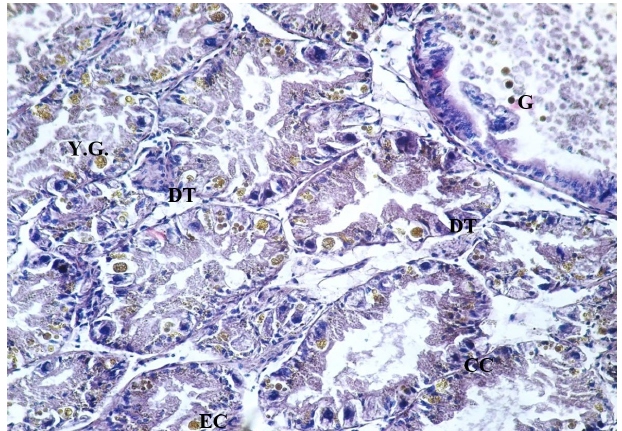
Fig. 2. Digestive gland of Helix aspersa muller snail in summer. Magnification 10×/0.25. D.T. – digestive tubules, CC – calcium cells, G.G. – green granules, Y.G. – yellow granules, E.C. – excretory cells Green granules are mainly in the vacuoles and are lim- ited to the distal edge of the cells, and yellow granules - are in the basal area.